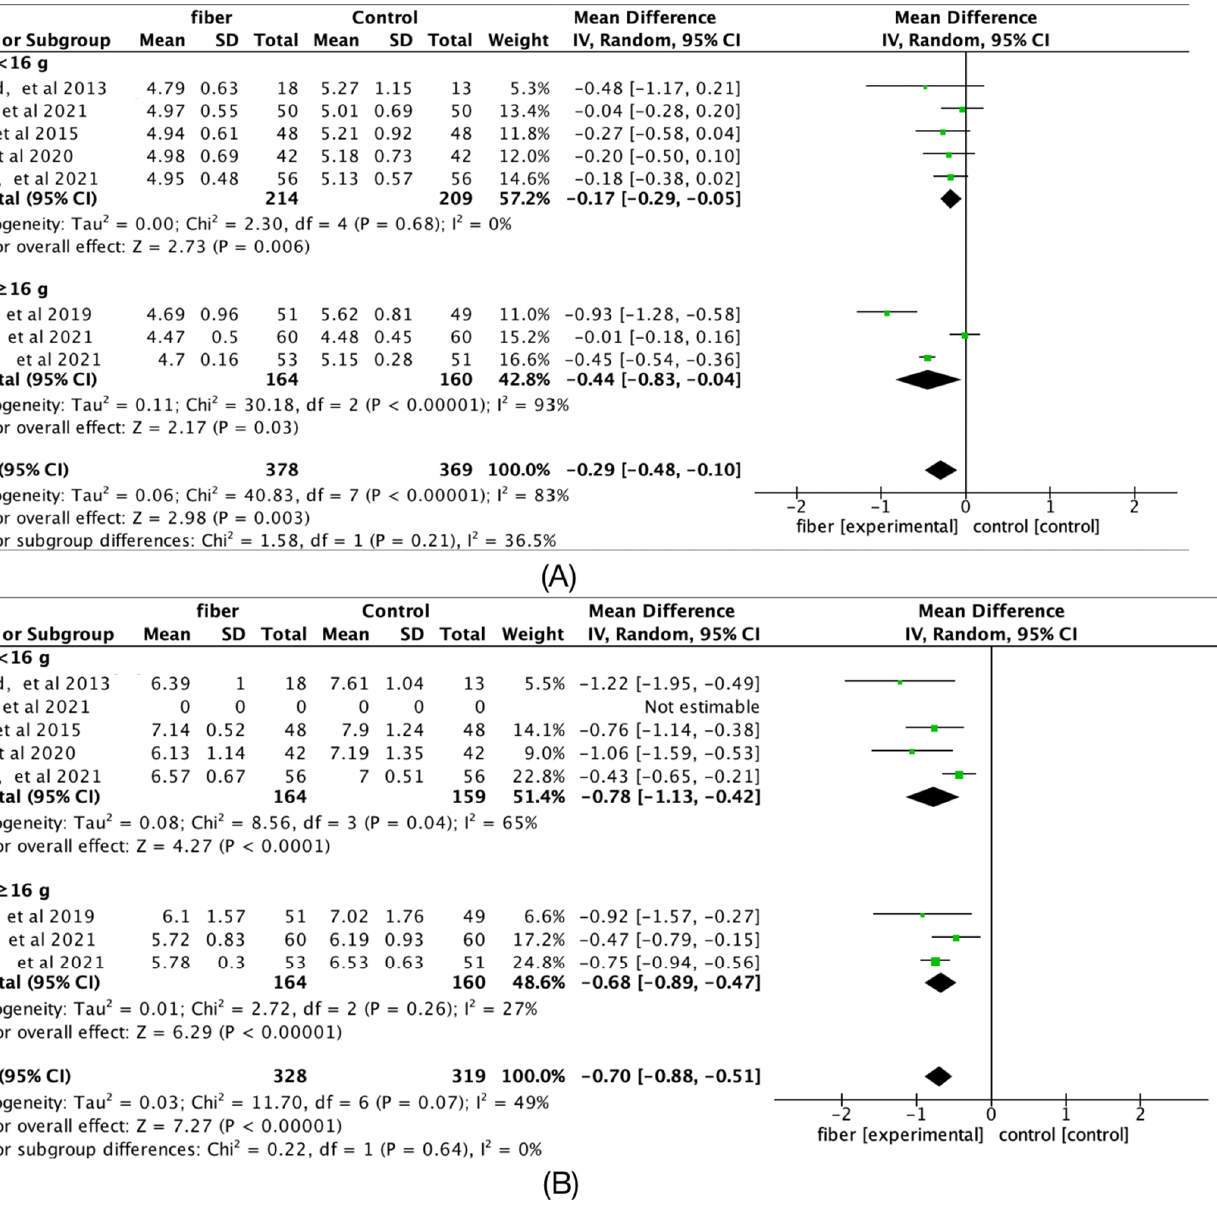
Figure 7. Forest plots of subgroup analysis of fiber quantity on ( A ) fasting glucose (mmol/L) and ( B ) 2-h glucose (mmol/L).[14–21]